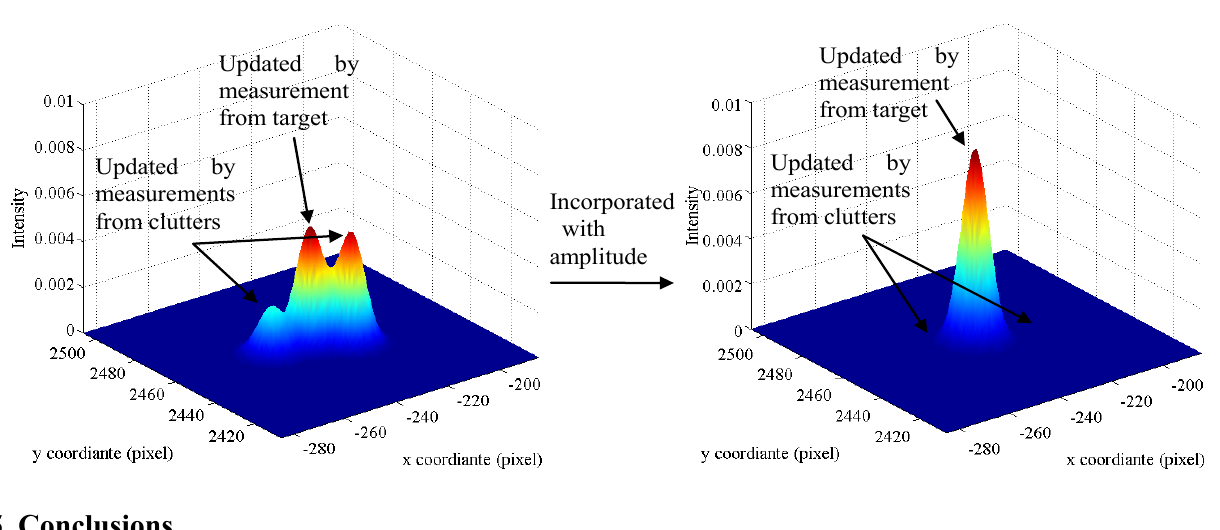
Figure 5. Intensity functions for generic PHD filter ( left ) and AI-PHD filter ( right